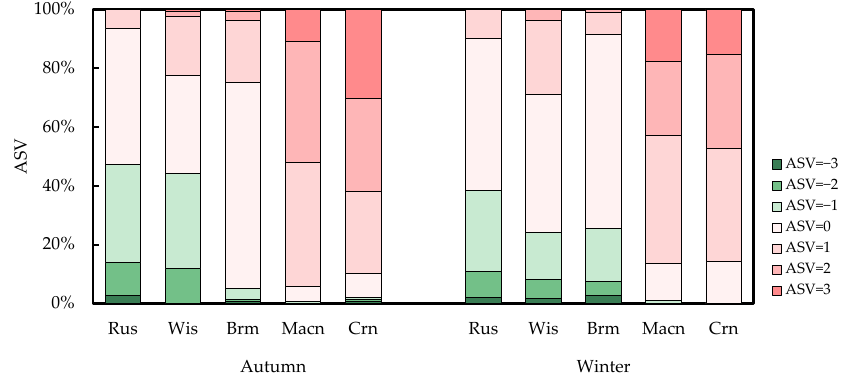
Figure 3. Distribution of the ASV among sound types.